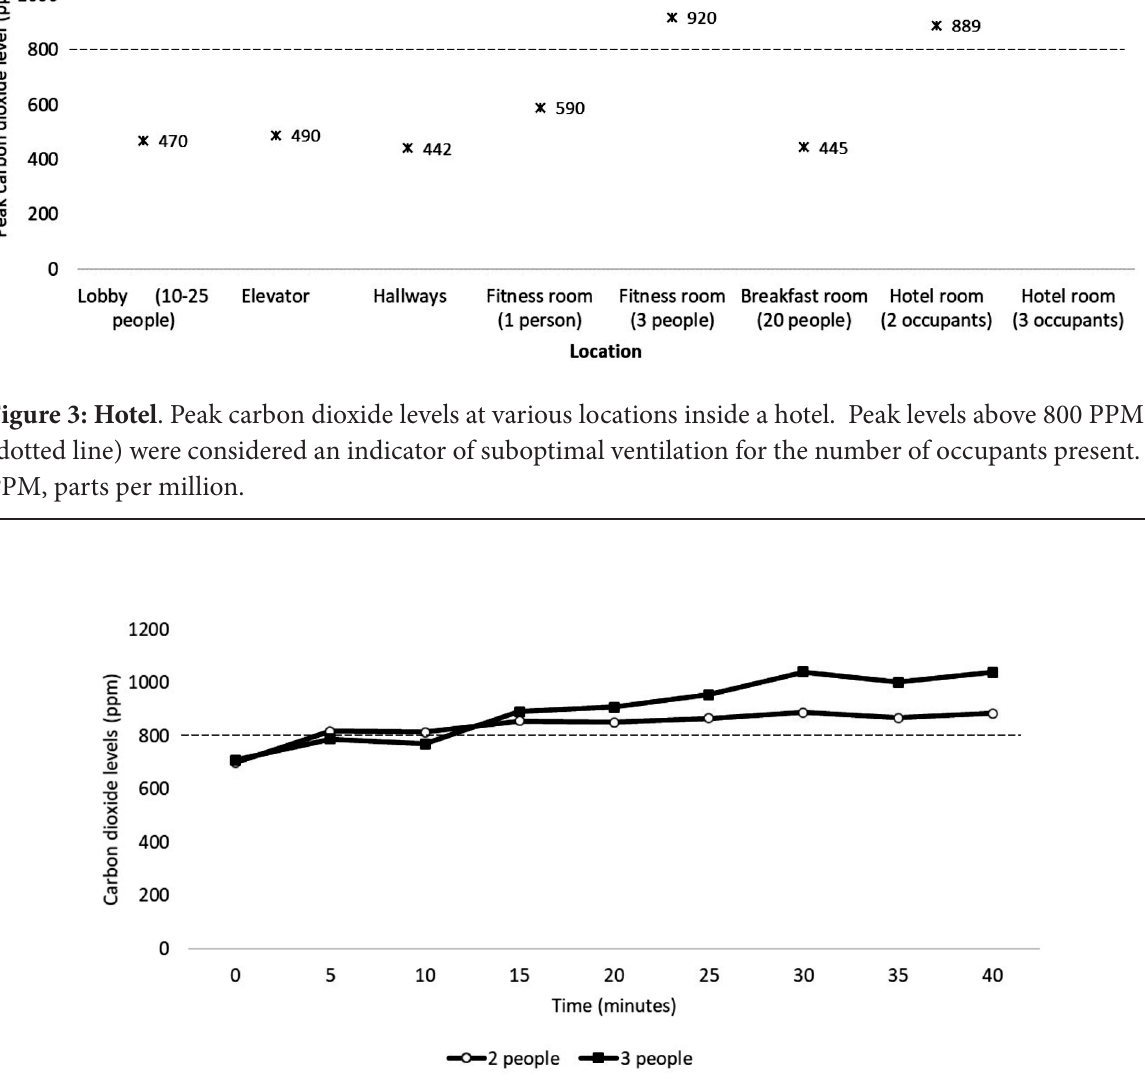
Figure 4 . Carbon dioxide levels in a hotel room with 2 or 3 occupants. The occupants entered the room at time 0. Peak levels above 800 PPM (dotted line) were considered an indicator of suboptimal ventilation for the number of occupants present. PPM, parts per